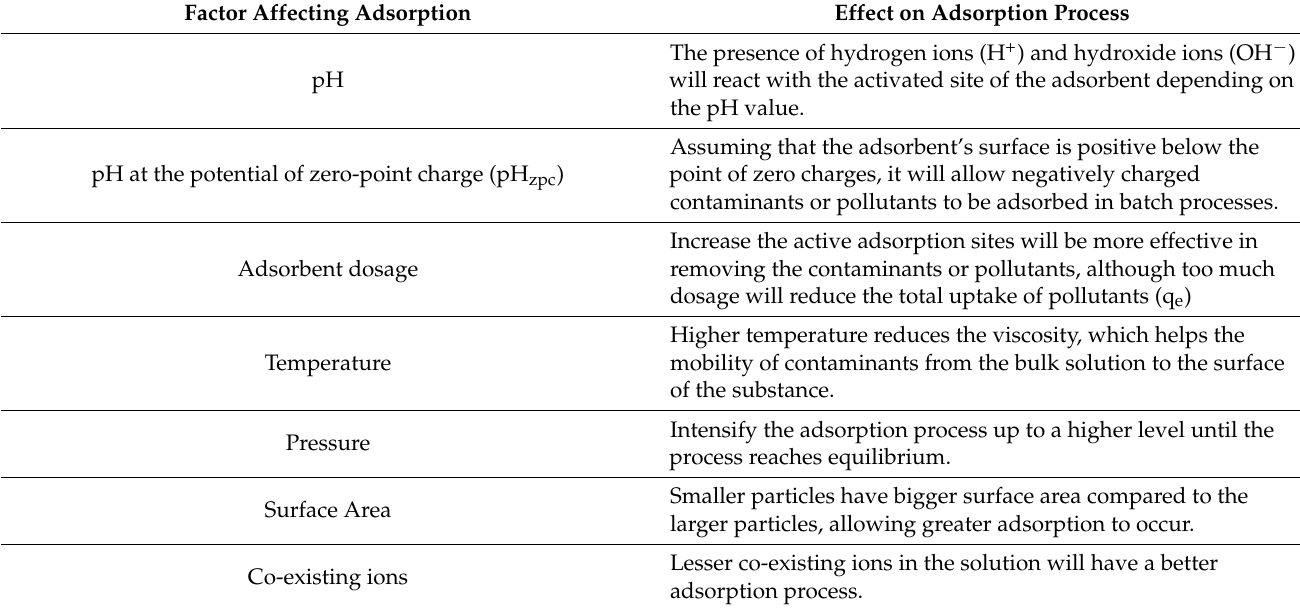
Table 7. Summary of factors that are affecting the overall adsorption’s